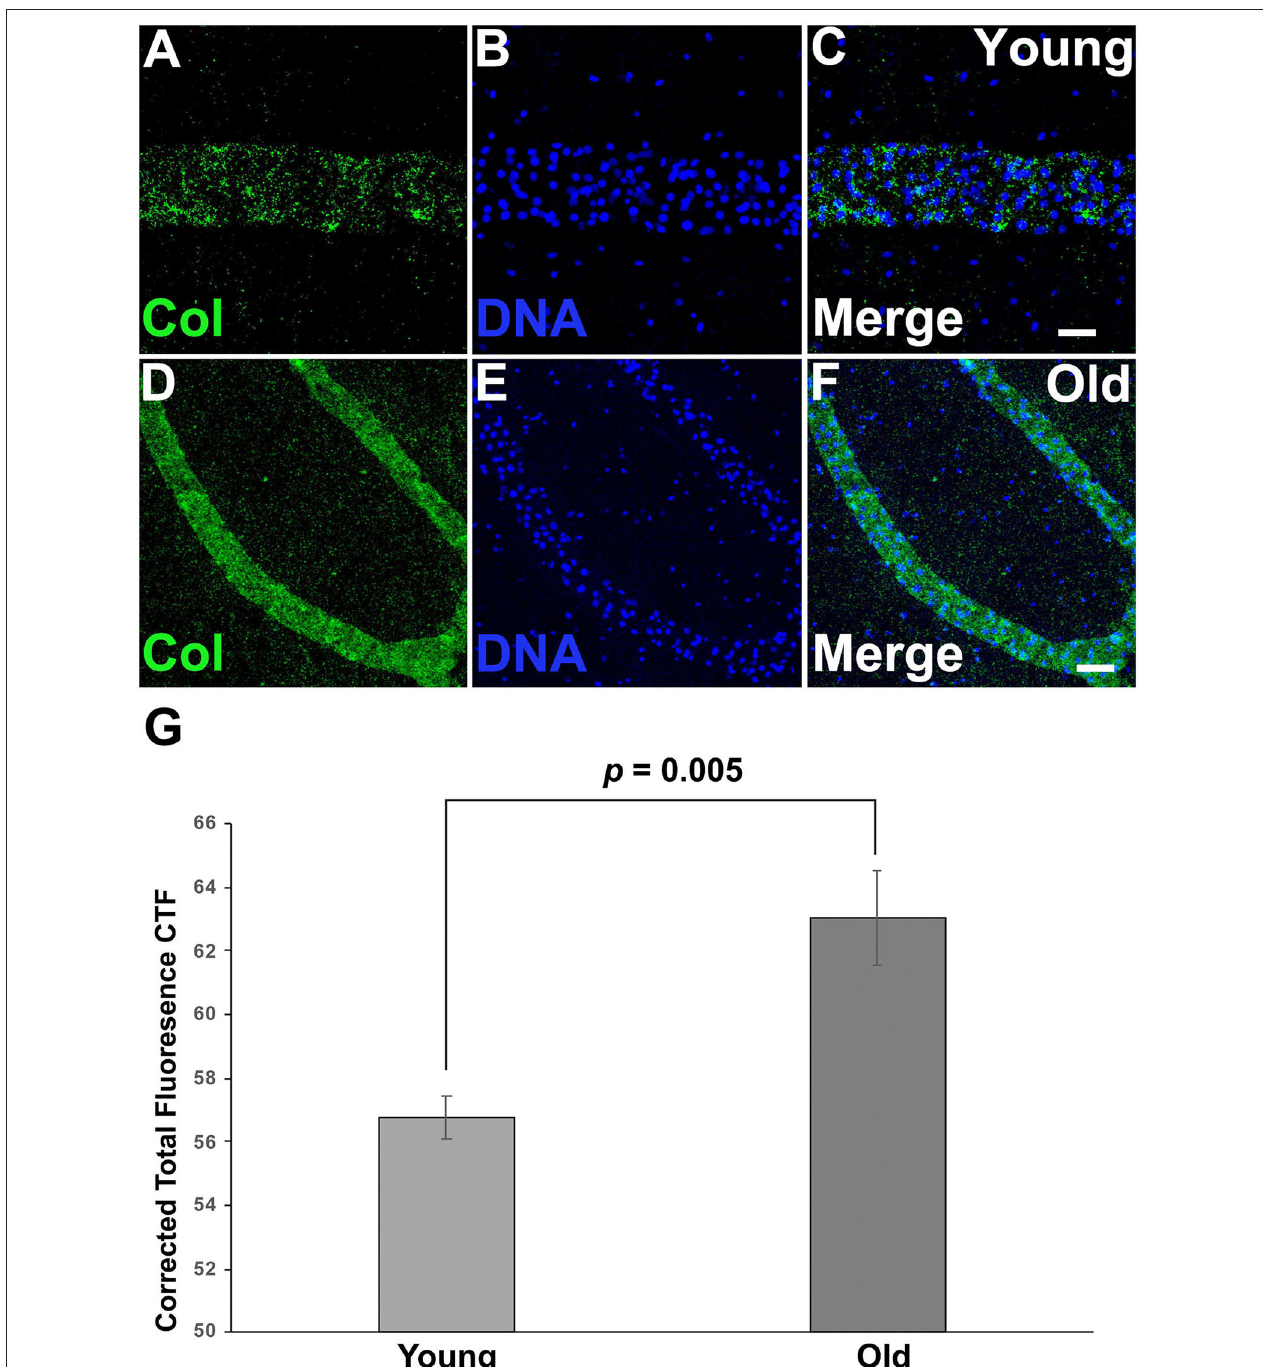
FIGURE 5 | Collagen is accumulated on aged vascular cells. (A–C) Young vessels show a sparse, punctate positive signal for putative Collagen immunostaining. (A) Representative image showing the fluorescent immunostaining of putative Collagen vessels of young vessels counterstained with Hoechst 33342 [ (B,C) merged]. (D–F) Old vessels show a strong accumulation of putative Collagen. (D) Representative fluorescent immunostaining of putative Collagen vessels of old vessels counterstained with Hoechst 33342 [ (E,F) merged]. (G) Corrected Total Fluorescence (arbitrary units) quantification of young vs old vessels. Statistical analysis was performed using the Student’s t -test. Scale bars: 10 µ